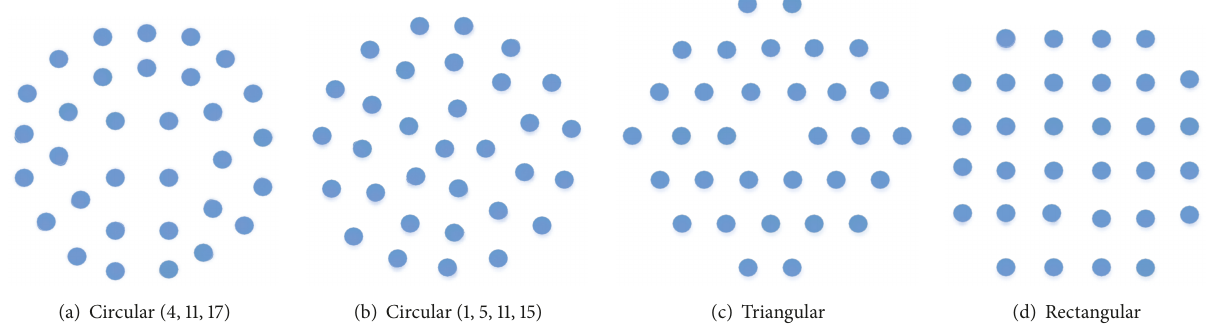
Figure 1: 32-QAM constellation